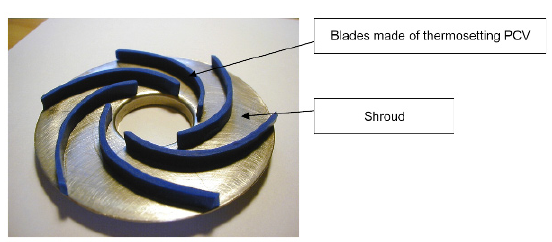
Figure 1. The impeller during assembly process.